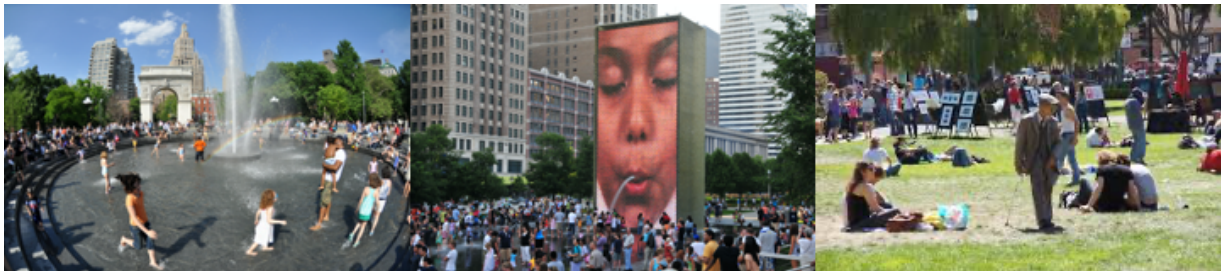
Fig. 7 SAGE social and urban science partners are exploring a network of software-defined sensor deployments at common venues in diverse cities (for example, public parks in (left-to-right) New York City, Chicago, San Francisco). Images from Wikimedia Commons, used without modification [59]